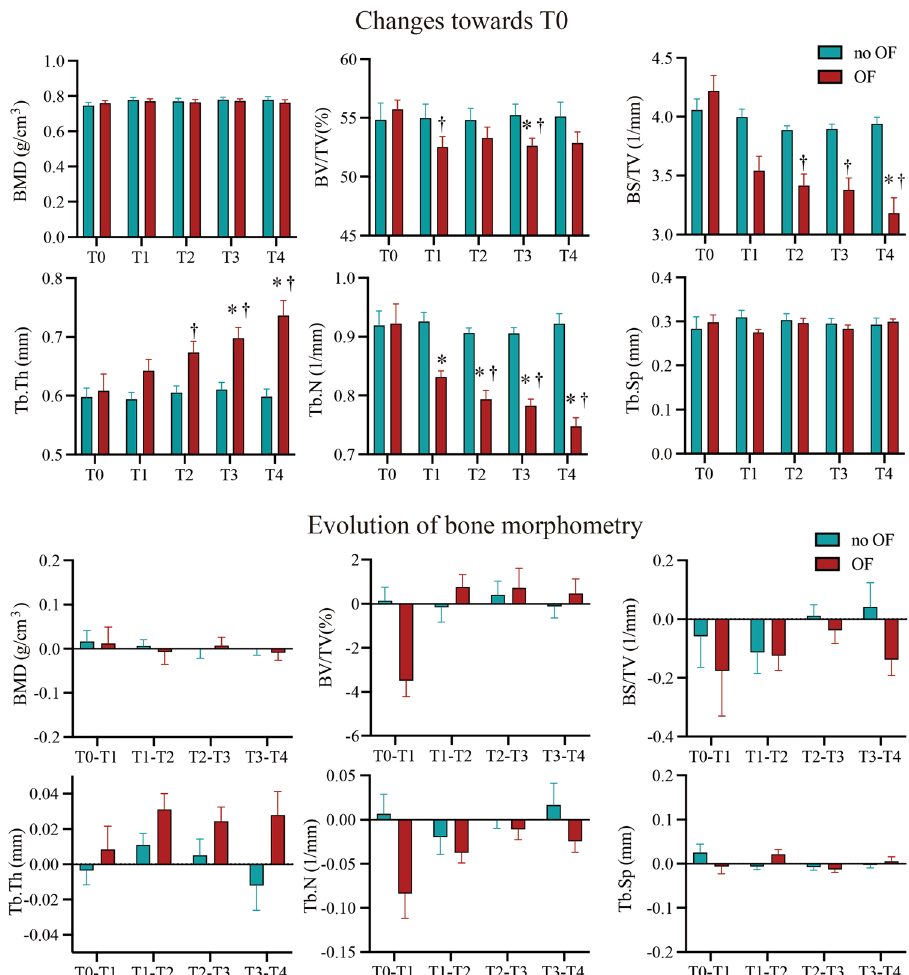
Figure 7. Dynamic changes in bone morphometry. The bone morphometric parameters were compared between different time points (T0–T4) and between the OF and no OF side by two-way repeated measures MANOVA and post-hoc Tukey’s test (n = 12). BMD = bone mineral density, BV/TV = bone volume fraction, BS/TV = bone surface density, Tb.Th = trabecular thickness, Tb.N = trabecular number, Tb.Sp = trabecular separation. * P < 0.01 versus no OF side. † P < 0.01 versus previous